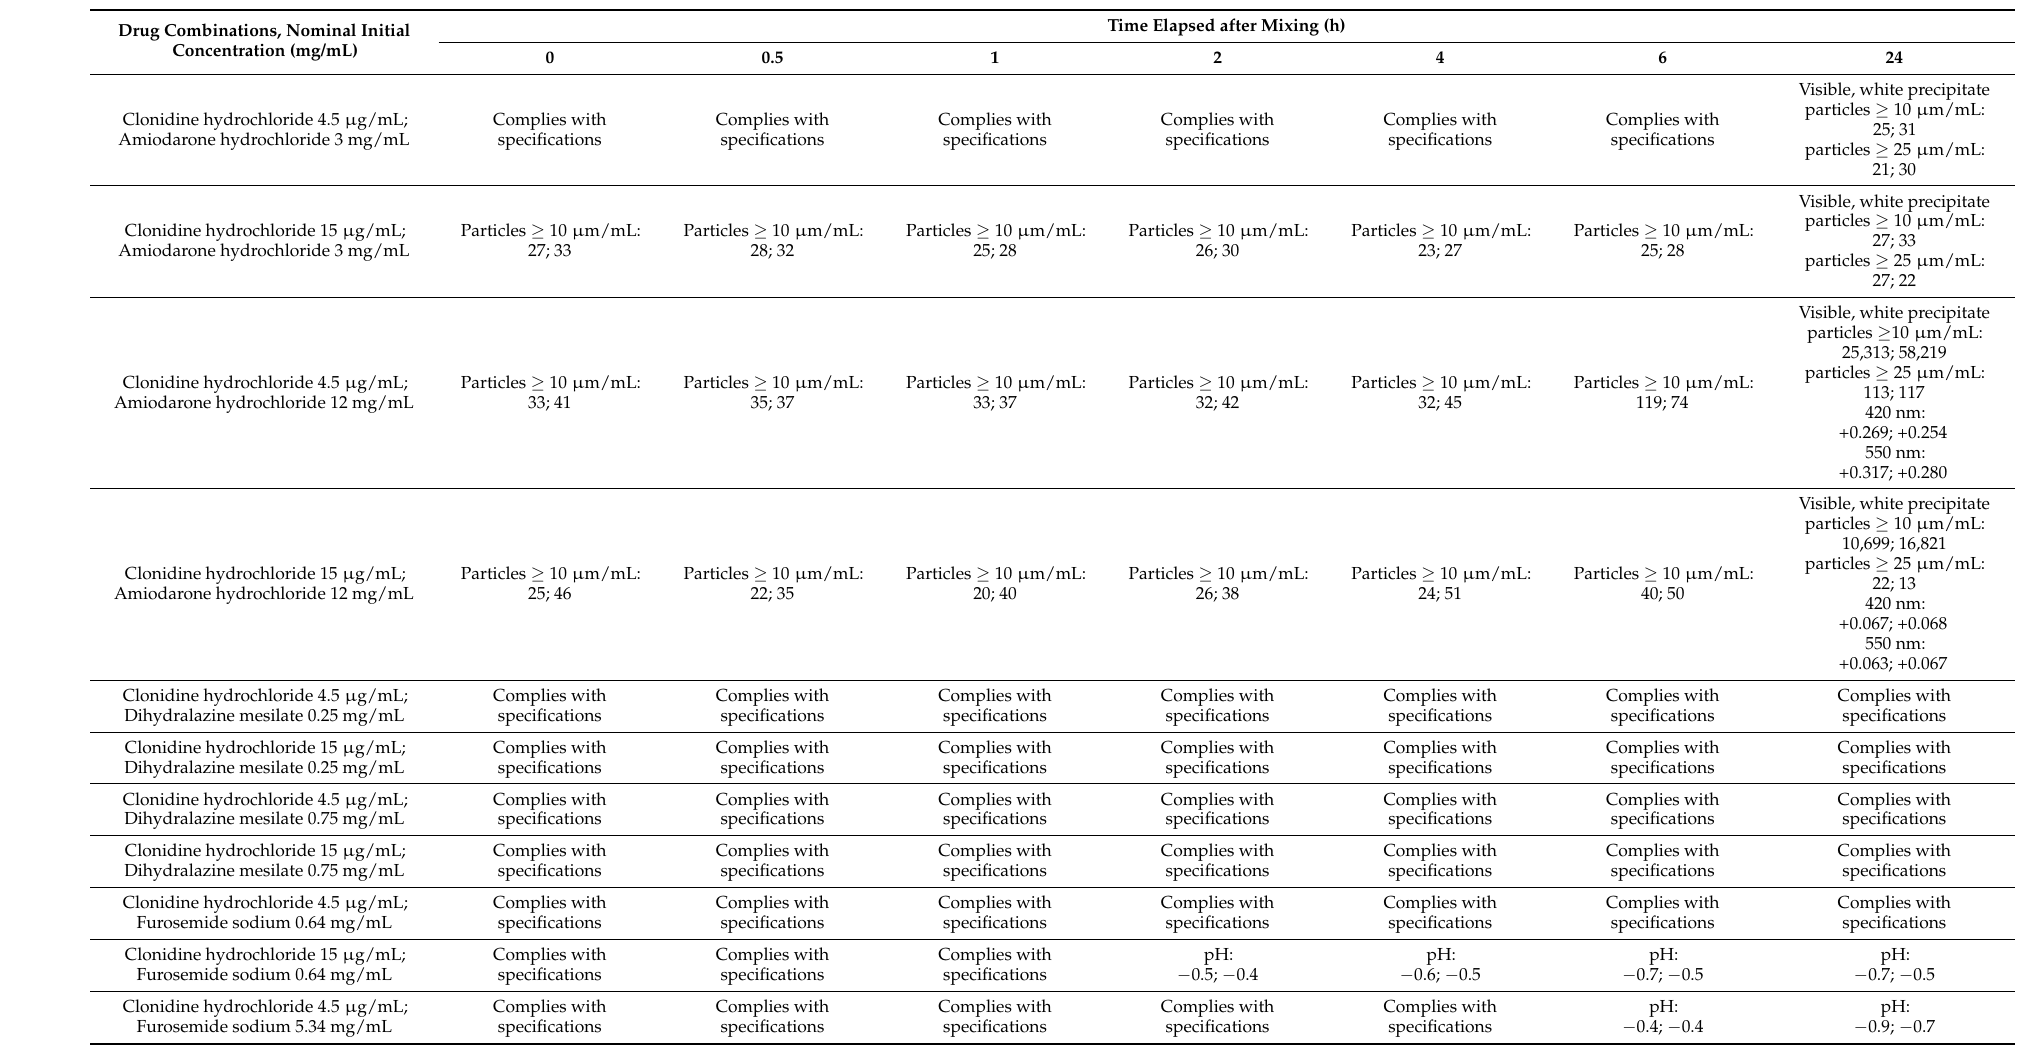
Table A3. Physical compatibility of binary